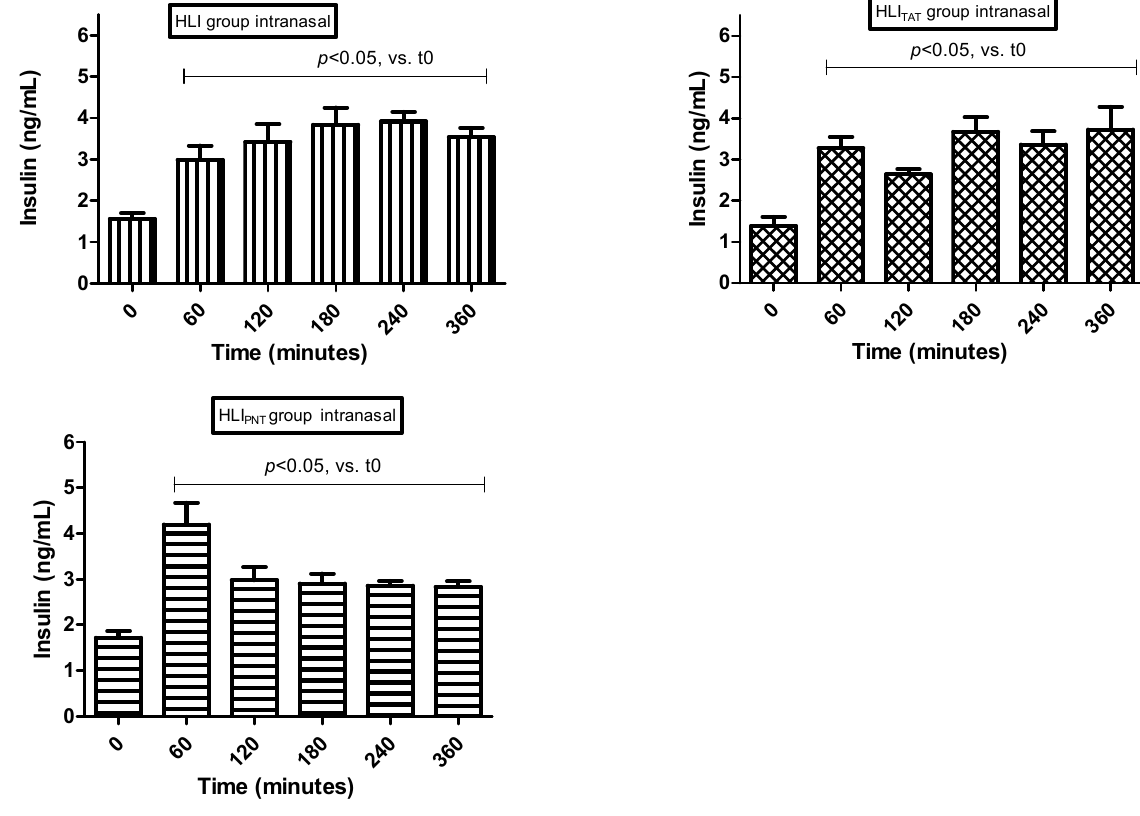
Figure 3. Serum insulin levels (ng mL − 1 ) in non-diabetic rats after intranasal administration of insulin. Insulin dose administered subcutaneously: 0.25 IU/animal. Insulin dose administered intranasally: 2.0 IU insulin/formulation/animal. Maximum volume of intranasal instillation: 100 µ L divided into 25 µ L applications introduced alternately in each nostril. (i) Intranasal administration of saline (0.85% NaCl) (SS nasal ); (ii) subcutaneous administration of 0.25 IU insulin (Novolin R ® ) (INSsub); (iii) intranasal administration of 2.0 IU insulin prepared in saline (INSnasal); (iv) nasal administration of HEC-based hydrogel containing 2.0 IU insulin (HI); (v) intranasal administration of HEC-based hydrogels containing 2.0 IU insulin-loaded liposomes (HLI); (vi) intranasal administration of HEC- based hydrogels containing 2.0 IU insulin-loaded liposomes functionalized with TAT (HLI TAT ); (vii) intranasal administration of HEC-based hydrogels containing 2.0 IU insulin-loaded liposomes functionalized with PNT (HLI PNT ).